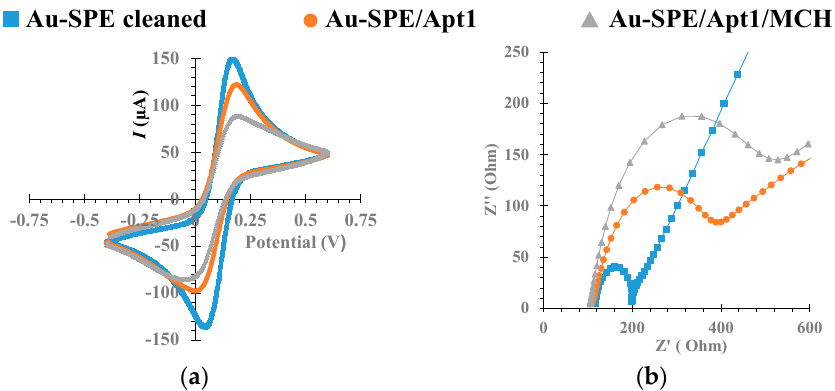
Figure 5. Electrochemical assays for construction of the biosensor by Au surface modification, in 5.0 × 10 − 3 M [Fe (CN) 6 ] 3 − and 5.0 × 10 − 3 M [Fe (CN) 6 ] 4- solution, prepared in phosphate buffer, pH 7.4. 5.0 × 10 − 3 M [Fe (CN) 6 ] 3 − and 5.0 × 10 − 3 M [Fe (CN) 6 ] 4 − solution, prepared in phosphate Cyclic voltammetry ( a ) and electrochemical impedance spectroscopy Nyquist plot ( b ).